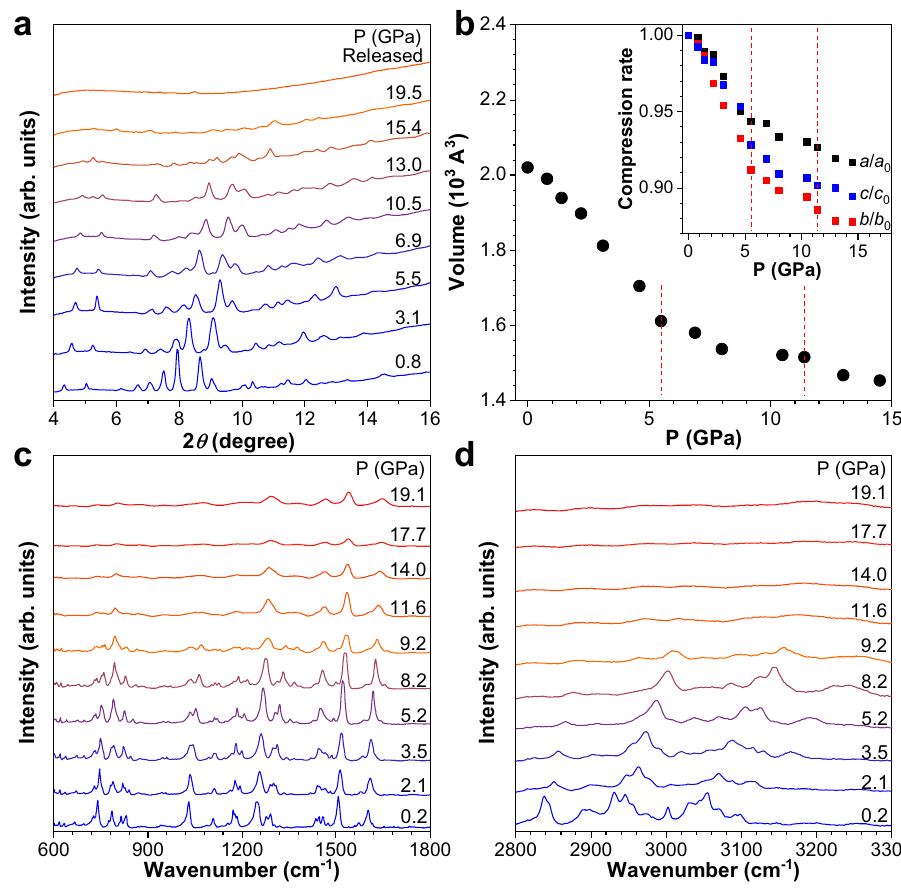
Fig. 2 | Structural evolution of FTPE crystal under high pressure. In situ ( a ) ADXRD patterns of the FTPE powder and ( b ) unit cell volume under pressure. The red dotted lines indicate isomorphic and crystalline-to-amorphous phase